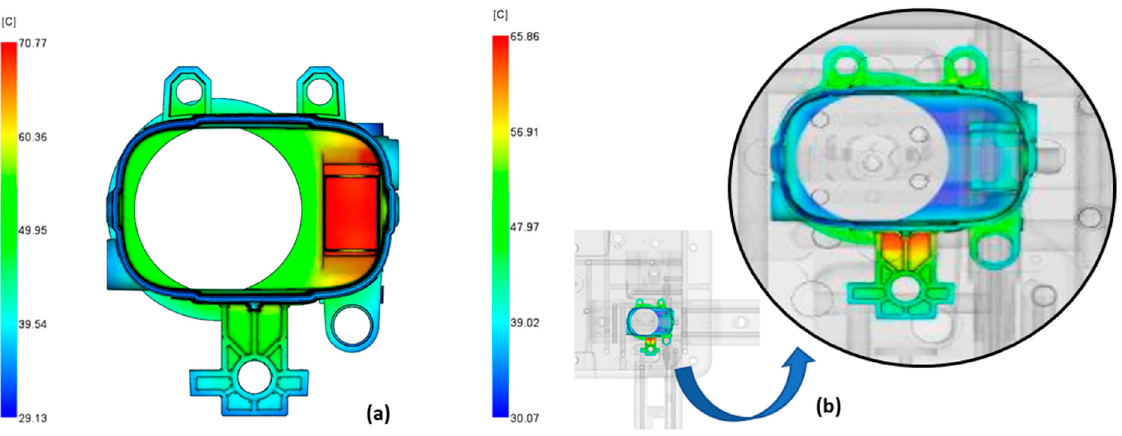
Figure 6. Tool–product interface temperature for conventionally cooled ( a ) and conformally cooled tool ( b ). tool ( b